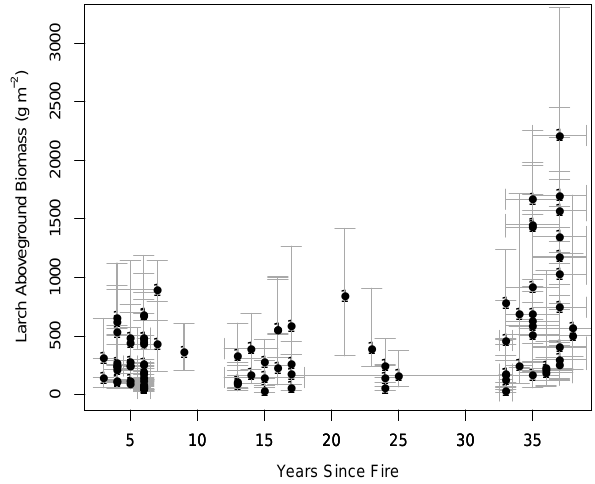
Fig. 8. Cajander larch aboveground biomass (AGB) across 98 fire scars that burned in the lower Kolyma River watershed between c. 1969–2005. Each point represents the median larch AGB in a fire scar, while y-error bars indicate 25th and 75th percentiles in AGB and x-error bars indicate the range of uncertainty in when the fire